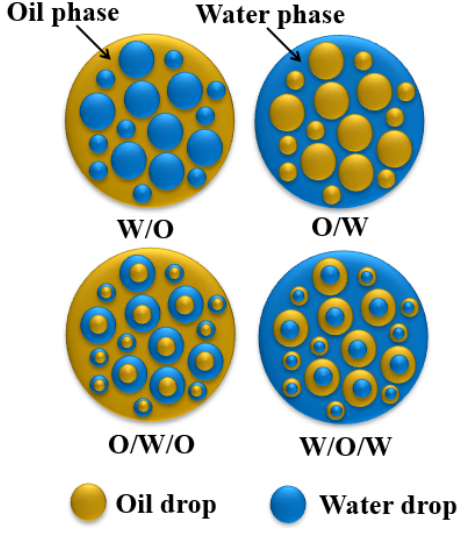
Figure 8. The types of heavy oil–water emulsions.